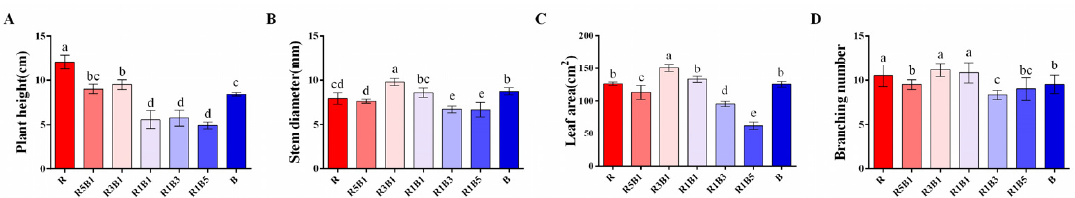
Figure 2. Plant height ( A ), stem diameter ( B ), leaf area ( C ), and branch number ( D ) of coriander plants as affected by the different spectra. Bars represent the mean ± SD ( n = 6). According to one way ANOVA, different letters denote statistically significant differences between treatments (Duncan’s test, p < 0.05). R: monochromatic red light; R1B5: red to blue ratio = 1:5; R1B3: red to blue ratio = 1:3; R1B1: red to blue ratio = 1:1; R1B3: red to blue ratio = 1:3; R1B5: red to blue ratio = 1:5; B: monochromatic blue light.